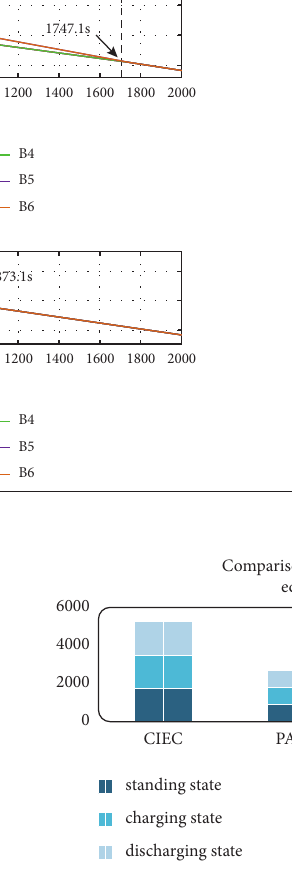
Table 5: Equalization results of the four equalizing circuits in the discharging state. CIEC 1747.1s